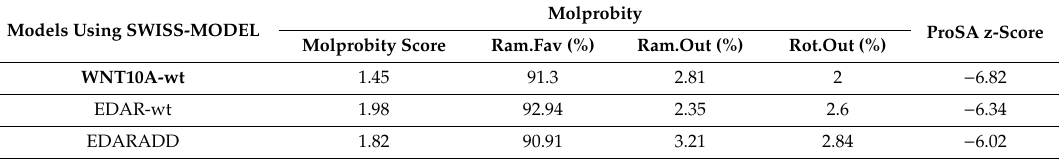
Table 1. Structure validation of homology models using Molprobity and ProSA z-score.